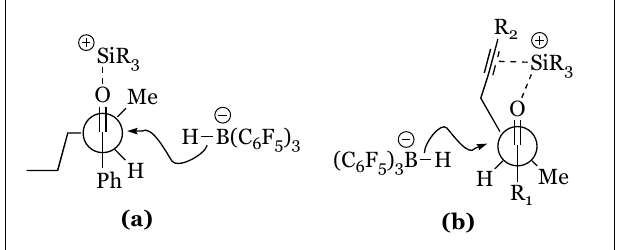
Figure 28. Felkin-Ahn models for: ( a ) propyl; ( b ) propargyl substituted reactants.